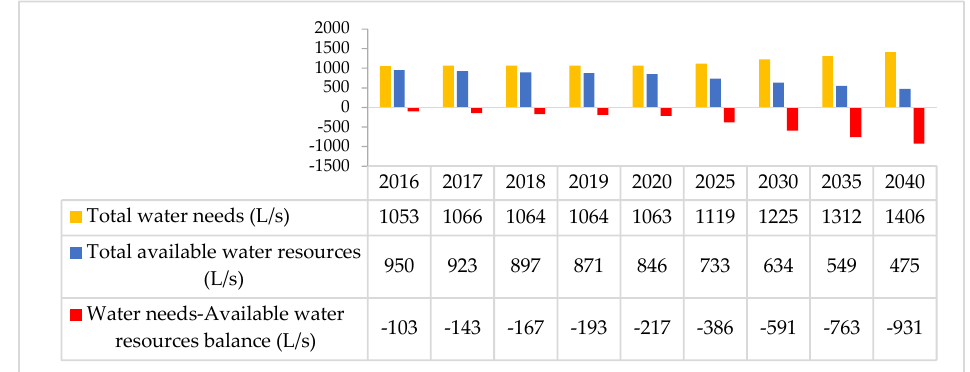
Figure 4. Estimation of drinking water needs—available water resources balance sheet of Oujda municipality (Pessimistic scenario).